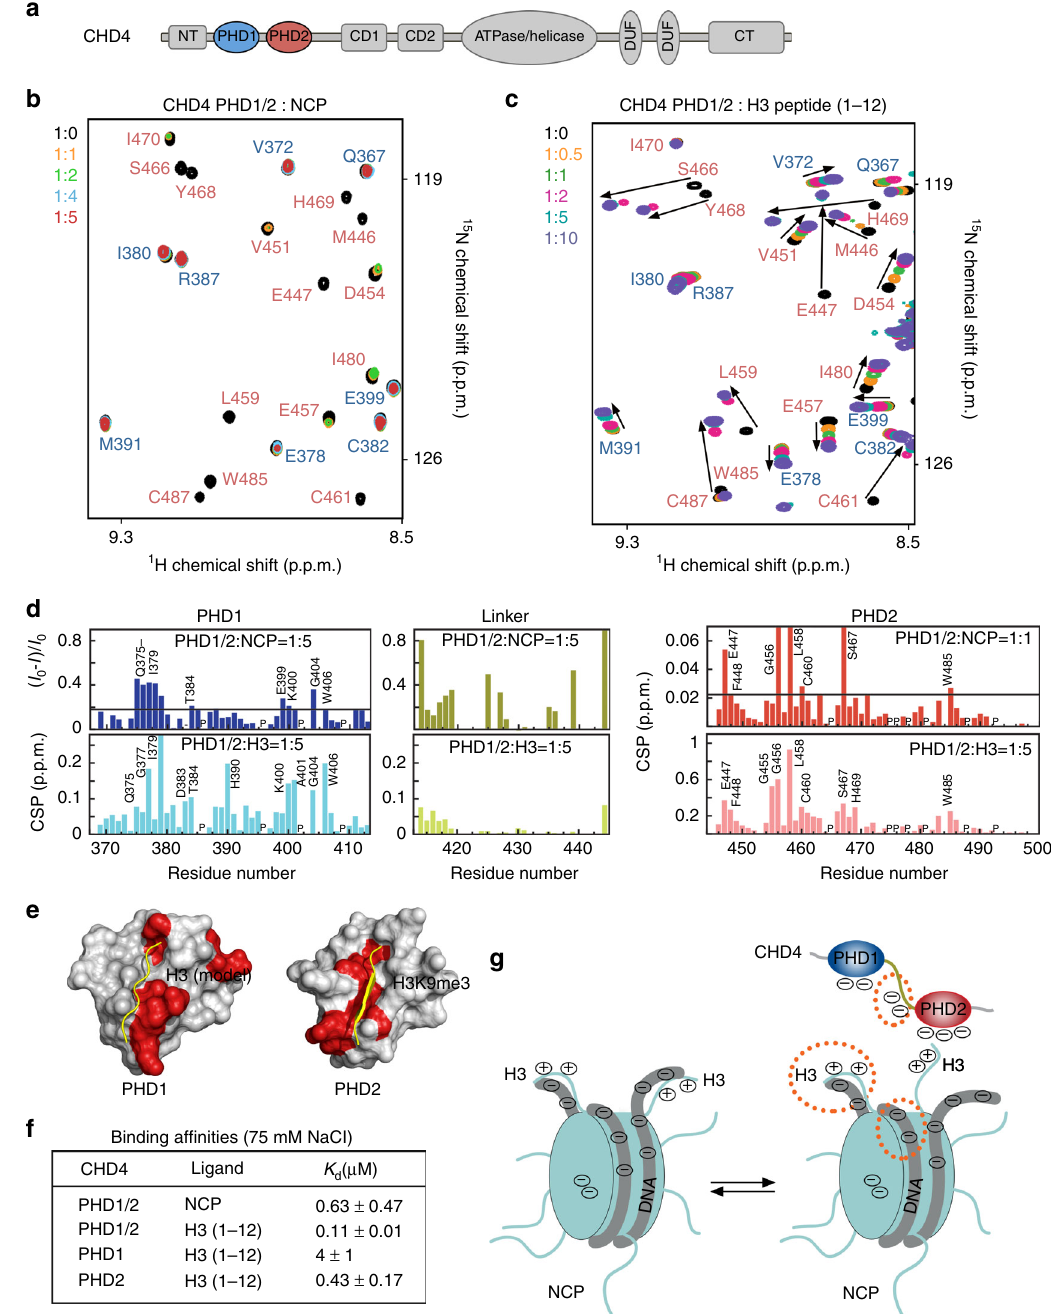
Fig. 1 Bivalent interaction of CHD4 PHD1/2 with the nucleosome. a Domain architecture of CHD4. b , c Superimposed 1 H, 15 N TROSY spectra of CHD4 PHD1/2 collected upon titration with ( b ) nucleosome or ( c ) histone H3 peptide (aa 1 – 12). Spectra are color coded according to the CHD4 PHD1/2:ligand molar ratio. Resonances of PHD1 and PHD2 are labeled in blue and red, respectively. d The bar-plots show fractional changes in intensity and CSPs in 1 H, 15 N TROSY spectra of PHD1/2 induced by the indicated molar ratios of NCP and H3 peptide. P denotes a proline residue. e Identi fi cation of the NCP- binding sites of PHD1/2. Residues that exhibit NCP-induced resonance perturbations (over average + SD in PHD1 and average + 2 SD in PHD2) in d are mapped onto the structures of the ligand-free PHD1 and H3K9me3-bound PHD2 (PDB IDs: 2L5U and 2L75). Histone H3 peptides are yellow. f Binding af fi nities of CHD4 PHD1/2 to NCP as measured by fl uorescence polarization and of CHD4 PHD1/2, PHD1, and PHD2 to H3 (1 – 12) peptide as measured by intrinsic tryptophan fl uorescence, in buffer containing 75 mM NaCl. Error is SD based on three separate experiments. g A model for the association of CHD4 PHD1/2 with the nucleosome. DNA is shown as a thick gray line. The negatively charged regions in NCP or CHD4 that in fl uence the PHD1/2 engagement with the nucleosome are encircled by orange